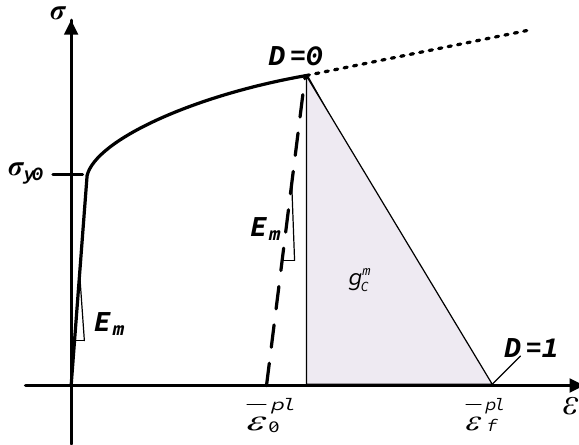
Figure 4. Stress–strain constitutive relationship of resin matrix.